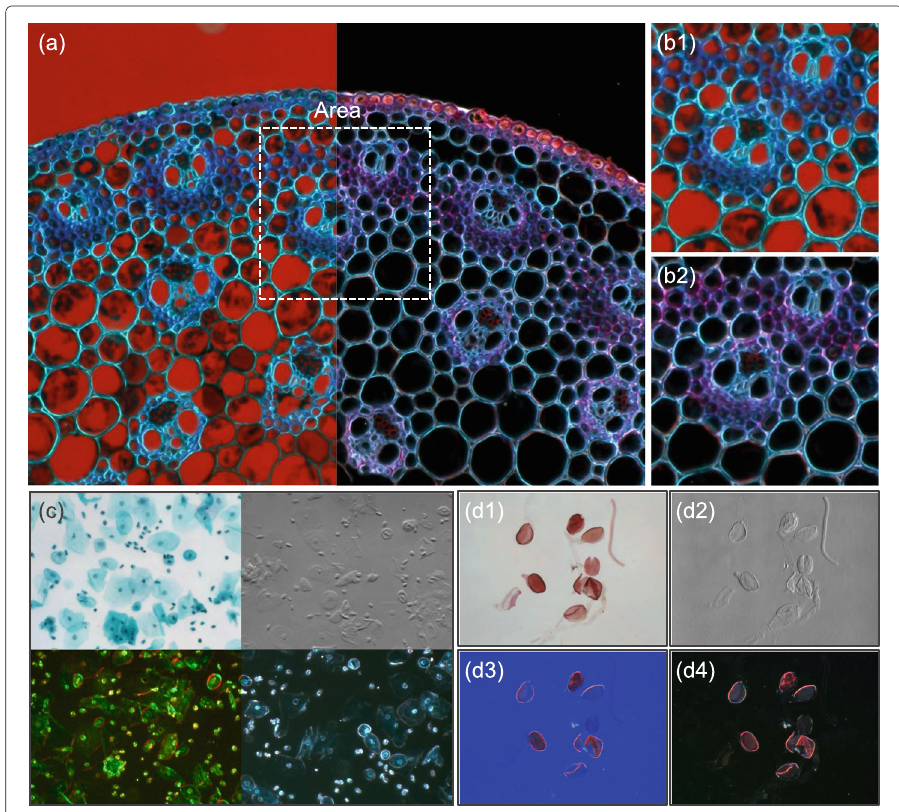
Fig. 23 Multi-contrast visualization results through sub-window segmentation displays or multi-window full FOV tiled display. (a) Stitching display view of two contrasts imaging results on maize slitting. (b1), (b2) The enlarged images of the Rheinberg and dark field results of the region of interest within the white dotted box in (a). (c) Stitching display view of four contrast imaging results on pathology specimen. (d1)-(d4) Four full FOV of multi-contrast images on pollen